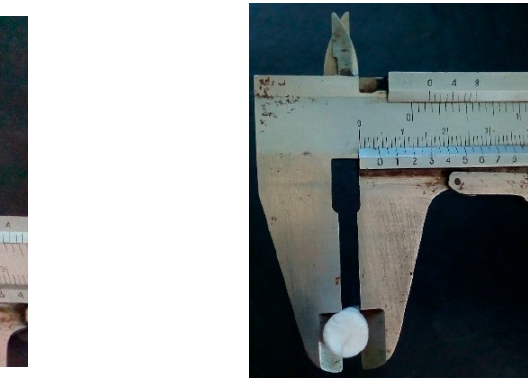
Figure 4. Cracked specimen for fretting ring distance above 70 mm ( left ), and deformed diameter ( right ).